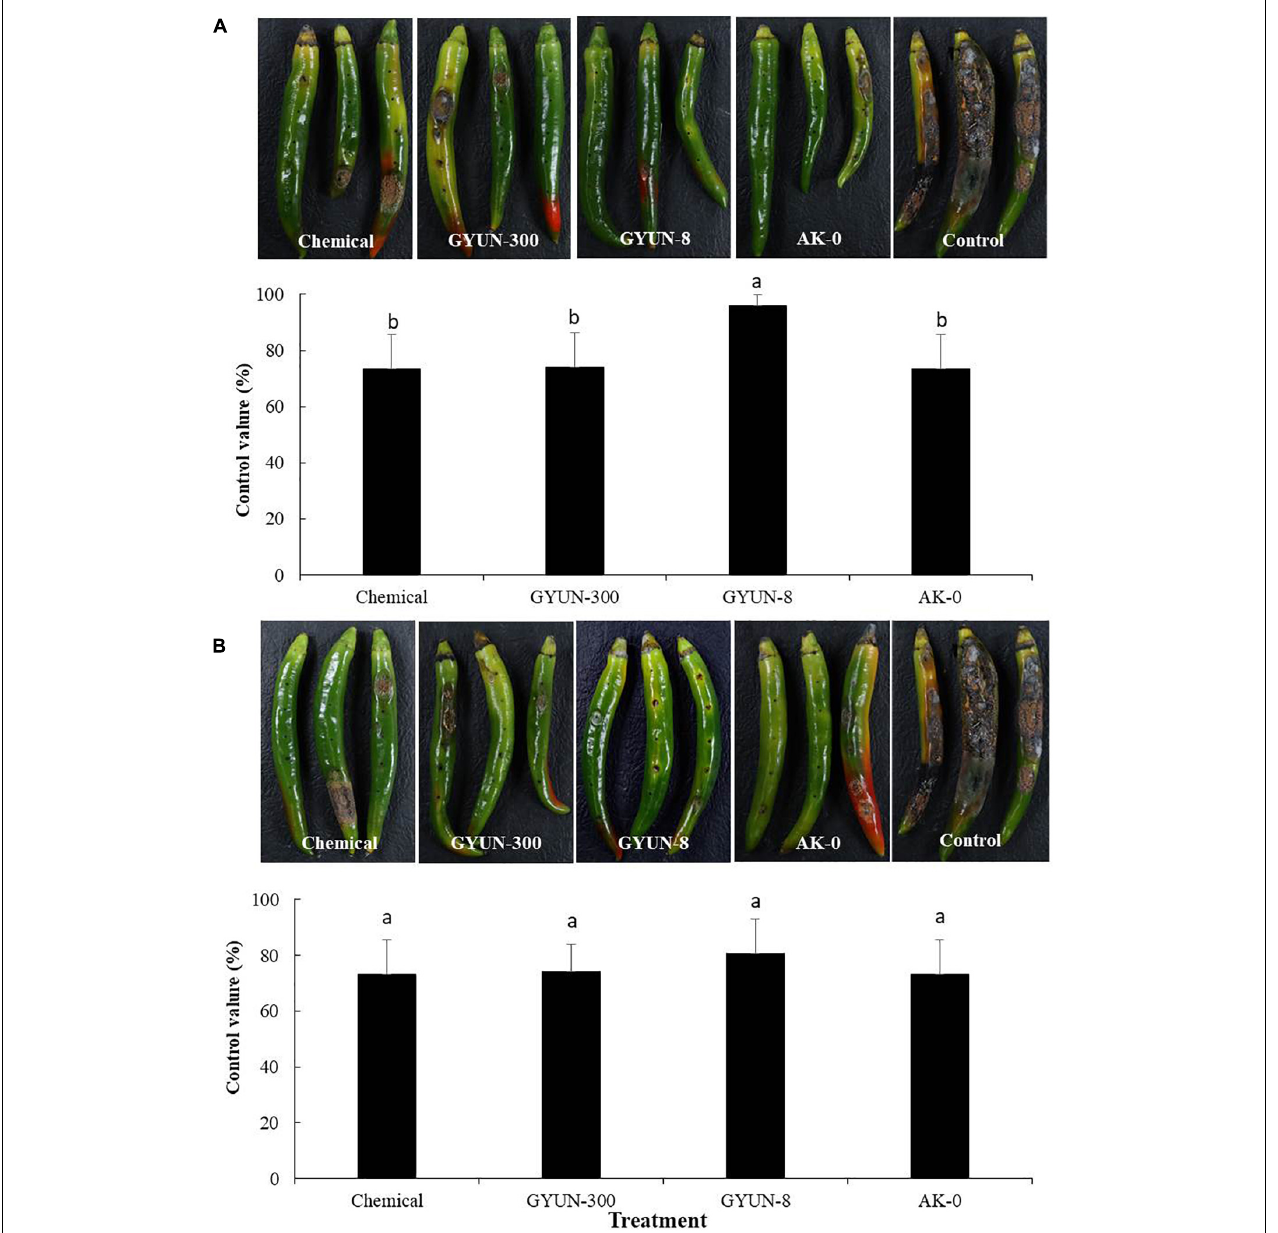
FIGURE 7 | Protective and curative effects of GYUN-300 on disease suppression of red pepper anthracnose in non-wounded fruits. (A) For protective effects, bacterial suspensions (10 7 CFU/mL) were sprayed on the detached green pepper fruits without wounding, followed by inoculation with Colletotrichum acutatum conidia suspensions (10 5 conidia/ml) on the same day. Disease severity (%) was recorded 14 days after incubation at 25 ◦ C. (B) For curative effects, symptoms were observed 14 days after pathogen inoculation with C. acutatum conidia suspensions (10 5 conidia/mL) on detached green pepper fruits without wounding, followed by treatment with bacterial suspensions (10 7 CFU/mL) using a spray method. Disease severity (%) was recorded 10 days after incubation at 25 ◦ C. The experiment was carried out two times with six replicates (fruits) per treatment, showing similar results. Bars with the same letters do not differ significantly between each other according to the least significant difference (LSD; p <